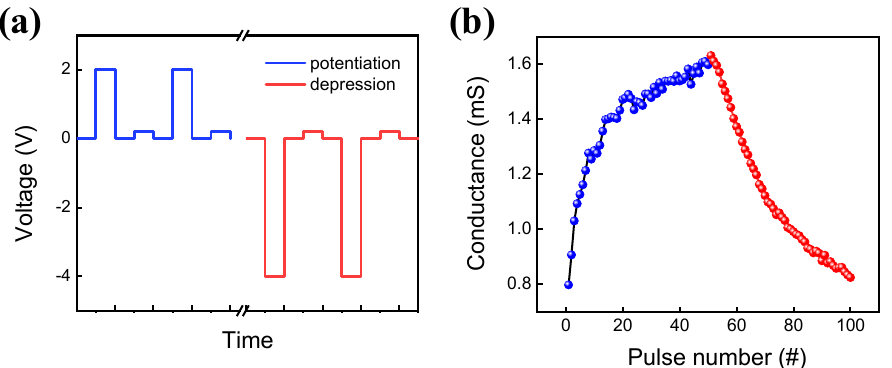
Figure 5. ( a ) Pulse schematic. ( b ) Potentiation and depression in cycles.